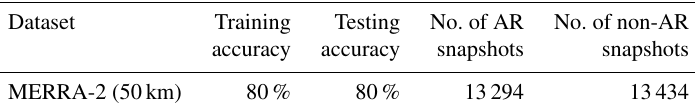
Table 5. Classification accuracy score estimated by the SVM classifier for 3-hourly temporal resolution and 50km spatial resolution of the MERRA-2 reanalysis. The table also shows the number of snapshots (number of events for both categories: ARs and non-ARs).